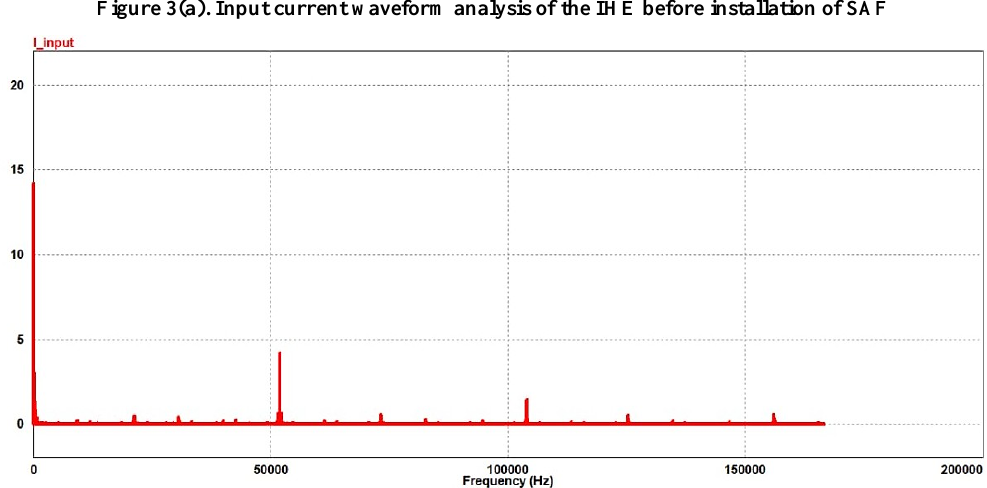
Figure 3(a). Input current waveform analysis of the IHE before installation of SAF